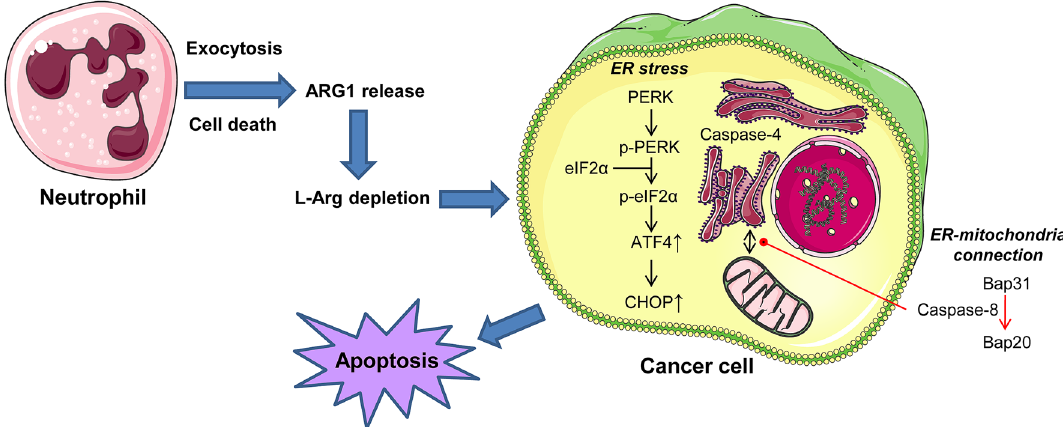
Figure 8. Schematic model of ER involvement in the induction of apoptosis in cancer cells following release of arginase-1 from human neutrophils. This is a schematic diagram to portray a plausible mechanism of how neutrophils can induce apoptosis in tumor cells following arginase-1 (ARG1) release. ARG1 is released from human neutrophils, either after cell activation leading to exocytosis of granule contents or after cell death. ARG1 leads to L-Arg depletion in the surrounding medium, and this induces an ER stress response and apoptosis in cancer cells. During this process, caspase-4 and -8 are activated, and there is an ER-mitochondria interplay mediated by the action of caspase-8 on Bap31. See text for details. Source: Own